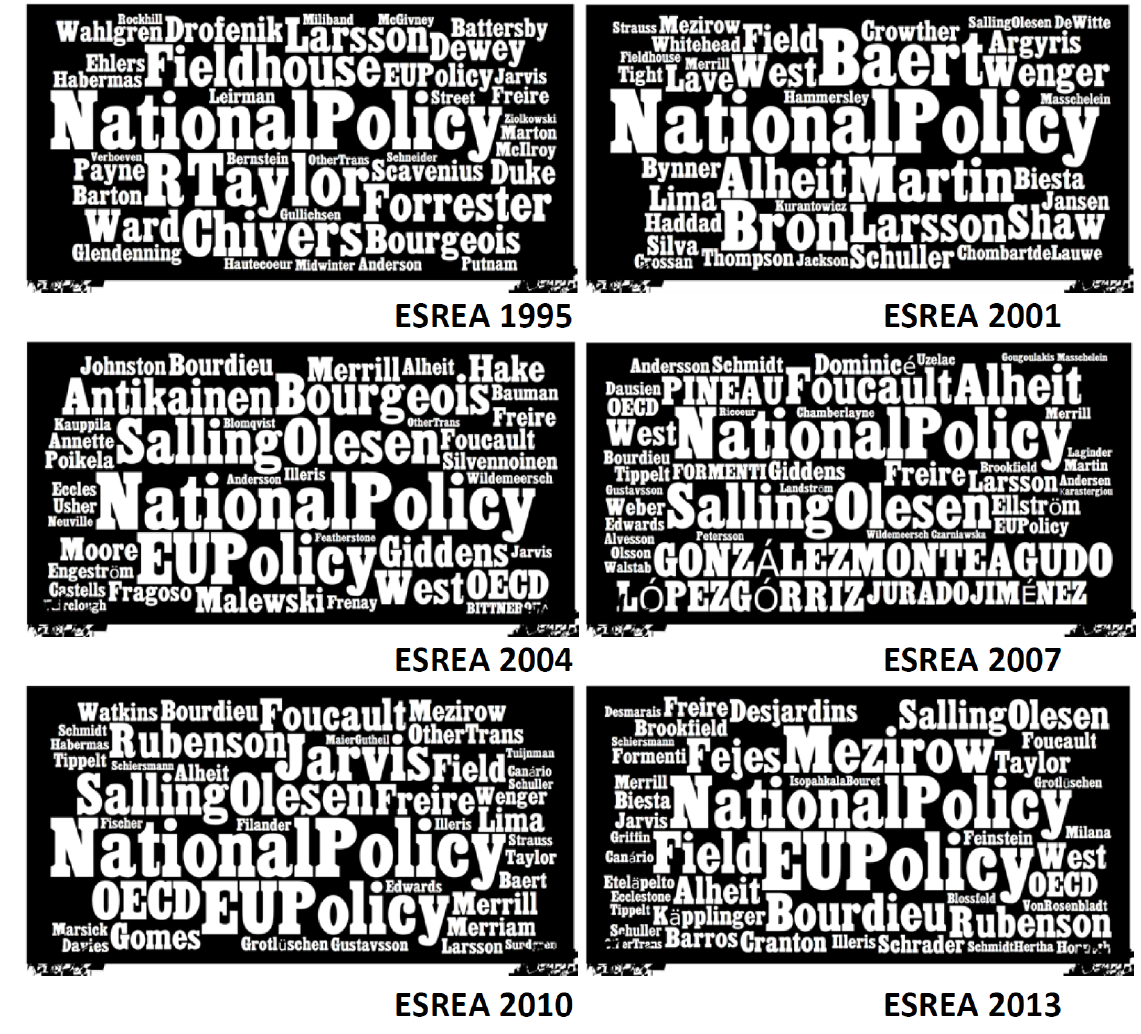
Figure 4: ESREA conferences and the most cited